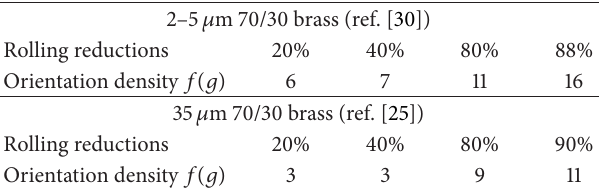
Figure 12: Variation of the orientation density 𝑓(𝑔) values for the B orientation for Cu-4.7Al and Cu-7Al, with four different initial grain sizes, plane strain compressed to a true strain of 1.0. Table 3: Orientation density 𝑓(𝑔) values for the B orientation for two grain sized 70/30 brass [25,